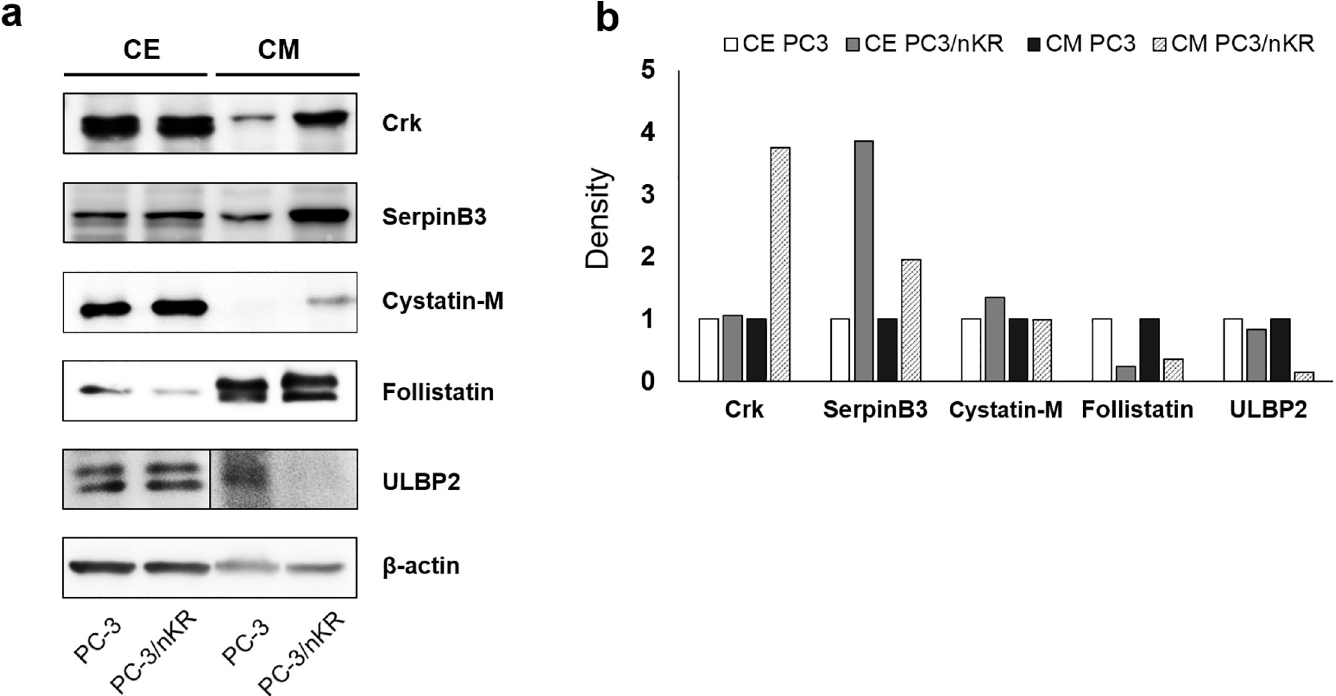
Fig 3. Validation of quantitative proteomics result using immunoblots. (A) Western blotting analysis of proteins with increased (Crk, SerpinB3, Cystatin-M), decreased (ULBP2), and unchanged secretion (Follistatin) in conditioned media (CM) and cell extract (CE) samples from PC3/nKR cells as compared with those from PC3 cells. (B) Densitometry results of Crk, SerpinB3, Cystatin-M, ULBP2 and Follistatin.